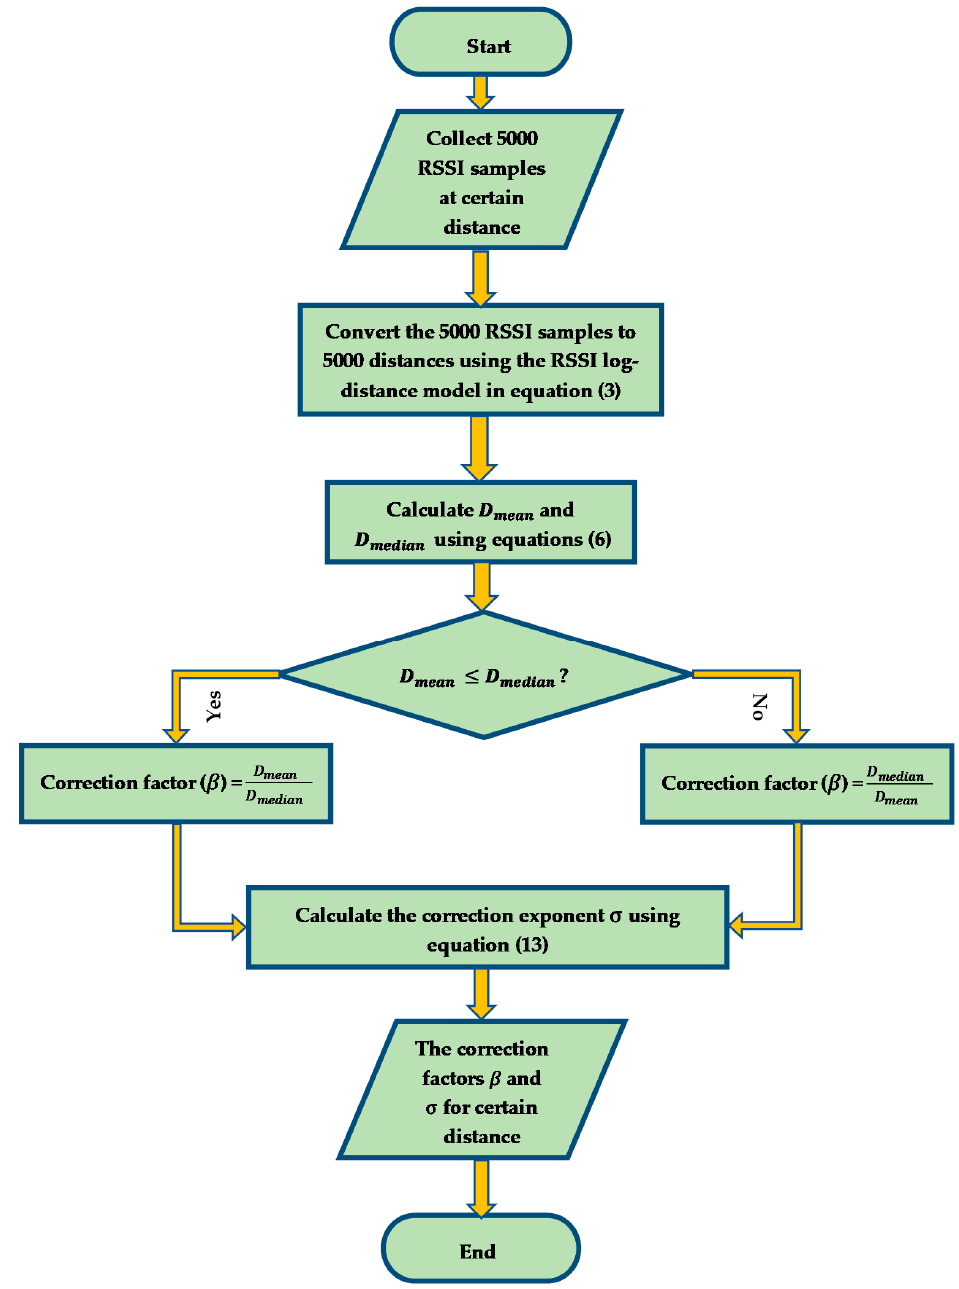
Figure 2. A flow chart of the RSSI distance prediction and correction algorithm for a certain dis- tance.